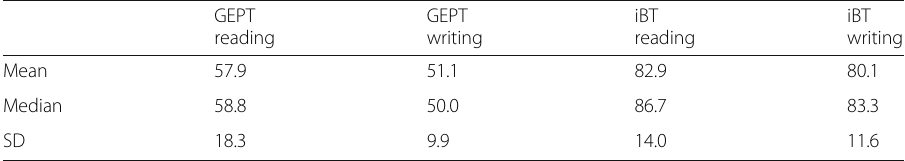
Table 6 Descriptive statistics for GEPT and iBT scores in percentage